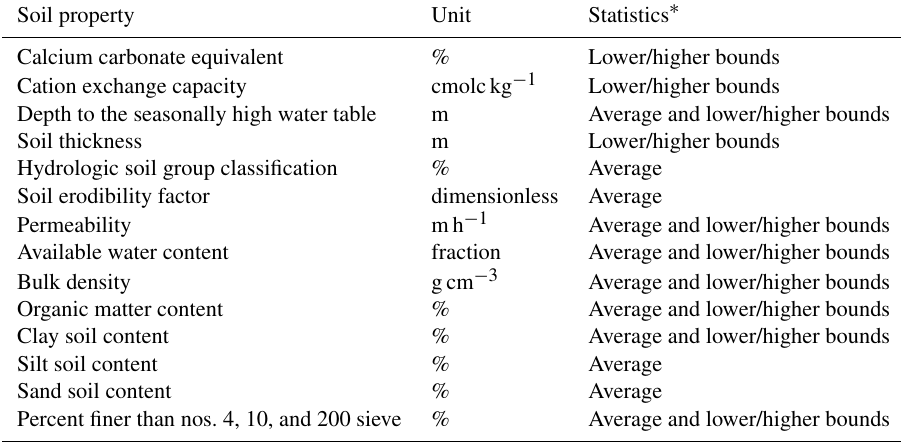
Table 3. Soil property predictors.